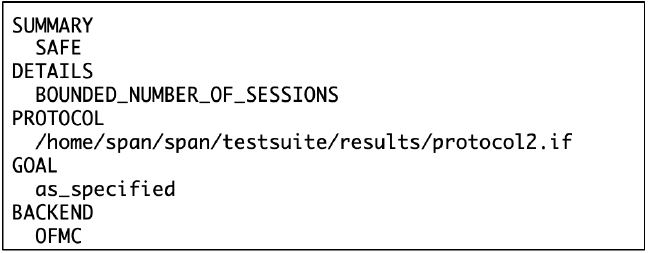
Figure 13. Output of OFMC backend for low security risk.